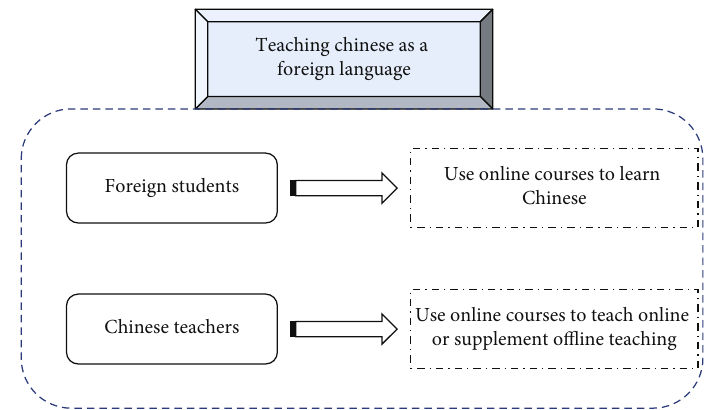
Figure 1: Teaching Chinese as a foreign language.